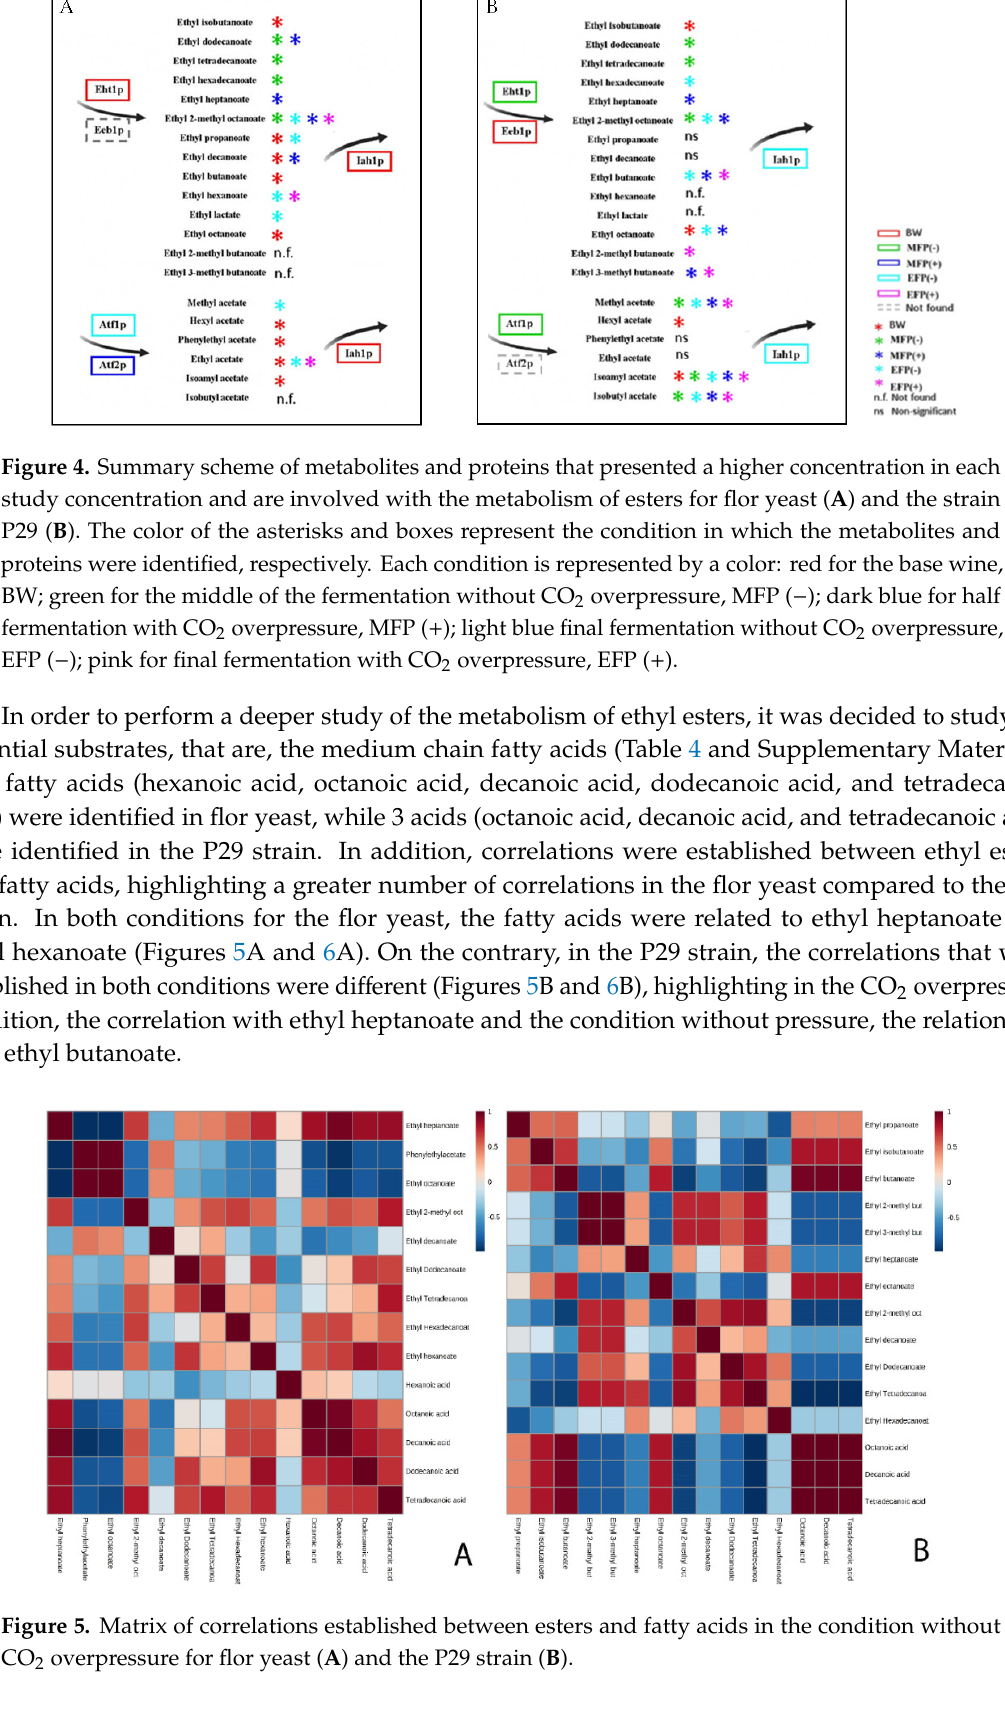
Figure 6. Matrix of correlations established between esters and fatty acids in the CO 2 overpressure condition for the flor yeast ( A ) and the P29 strain ( B ). Finally, a multivariate analysis of the principal components was carried out to discriminate between the variables those that separate the flor yeast from the P29 strain. The PCA obtained (Figure 7) explained 89.870% of the total variance. PC1 (67.663%) separated with positive values the flor yeast to the P29 strain, with negative values. The variables that separated the flor yeast were hexanoic acid (0.246), tetradecanoic acid (0.246), and Atf2p (0.234). However, the acetate esters were the variables that discriminated against the P29 strain. These esters were ethyl acetate (–0.246), isoamyl acetate (– 0.246), hexyl acetate (–0.241), and phenylethyl acetate (–0.247).